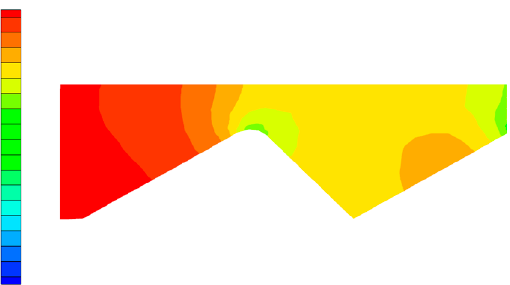
Figure 9. Turbulent flow pressure nephogram.